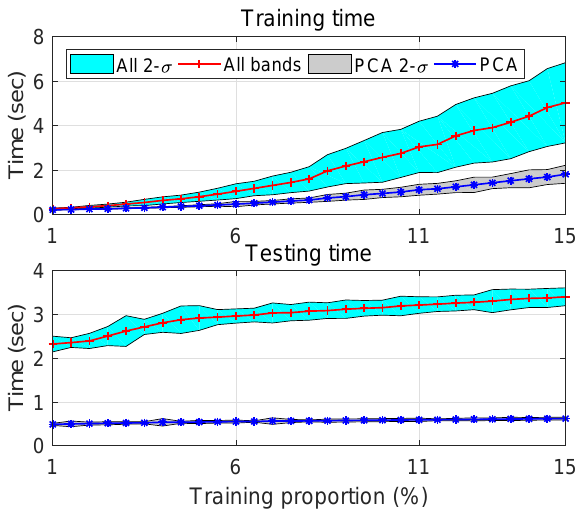
Figure 19. Comparative results of computation time under different sizes of training dataset including training time (upper plot) and testing time (lower plot): mean (red+ line) and 2- σ region (green area) of all bands, mean (blue* line) and 2- σ region (gray area) of PCA.